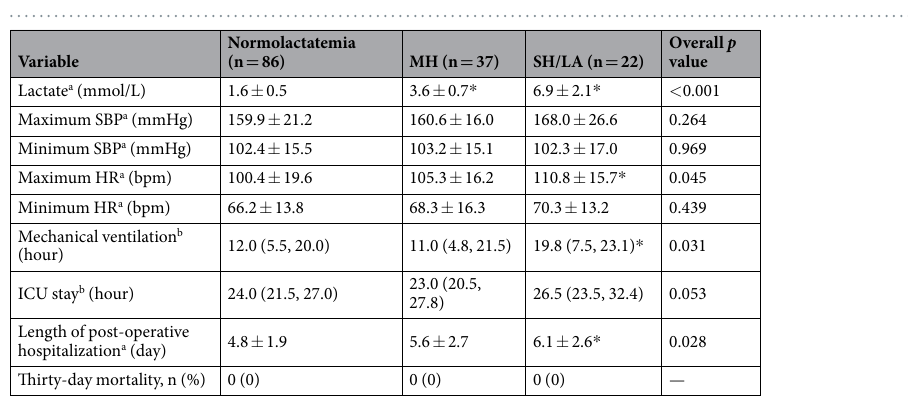
Table 3. Intra-operative variables. MH, moderate hyperlactatemia; SH/LA, severe hyperlactatemia/lactic acidosis; SBP, systolic blood pressure; HR, heart rate. * p < 0.05 vs the normolactatemia group. a Mean ± standard deviation; b median (25th percentile, 75th percentile).